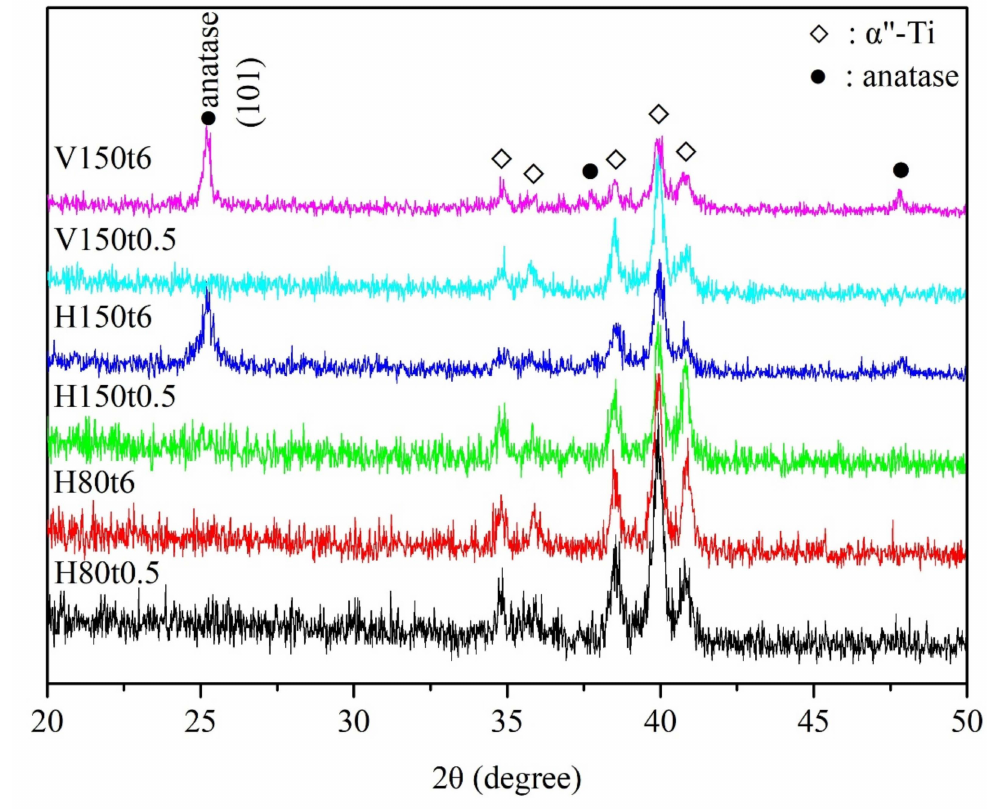
Figure 1. XRD patterns of anodized Ti–5Nb–5Mo under various hydrothermal or vapor thermal treatments. The SEM photographs of the Ti–5Nb–5Mo sample after anodization and hydrothermal or vapor thermal treatment under various conditions are presented in Figure 2. After hydrothermal treatment at 80 ◦ C for 0.5 h (H80t0.5), the nanotube morphology remained intact, with no obvious precipitate on its surface (Figure 2a). After 6 h of treatment (H80t6), precipitates were observed along the orifice edges of the nanotubes (Figure 2b). Moreover, the observed nanotube structure was not continuous but rather had a discrete structure with gaps between adjacent nanotubes and a thickened tube wall. After the hydrothermal reaction conducted at 150 ◦ C for 0.5 h (H150t0.5), some granular precipitates with a